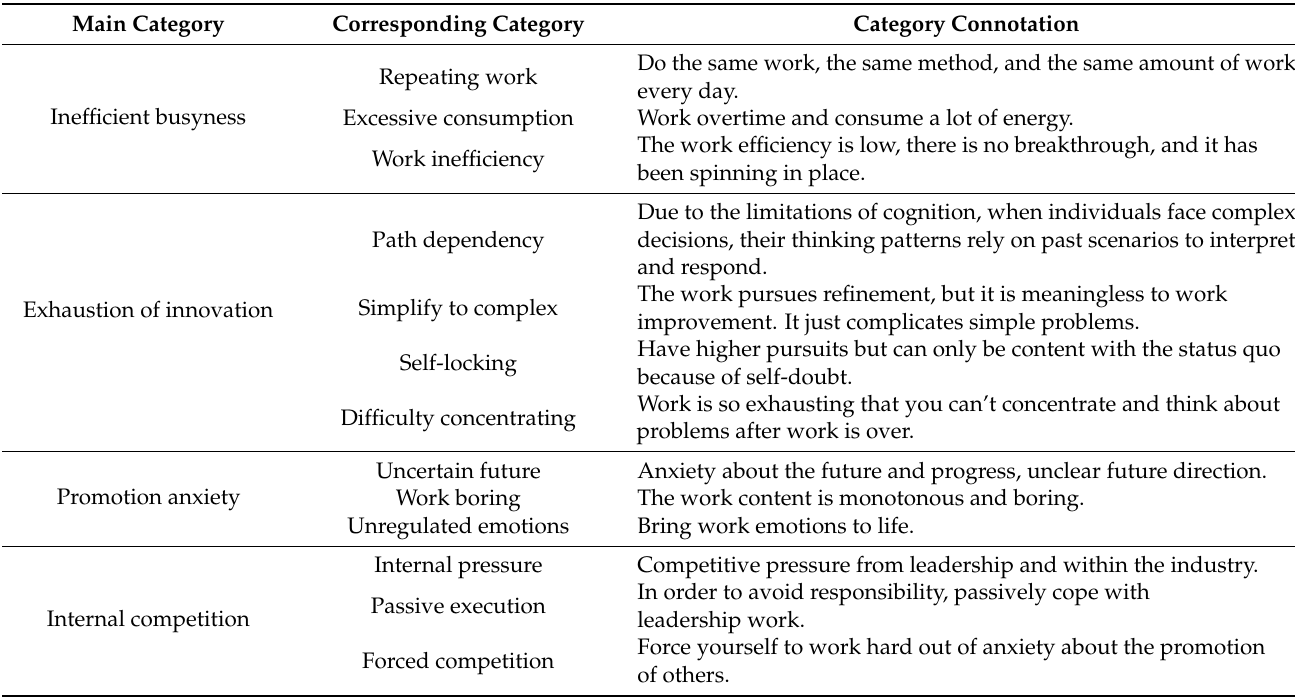
Table 4. Process and results of axial coding.